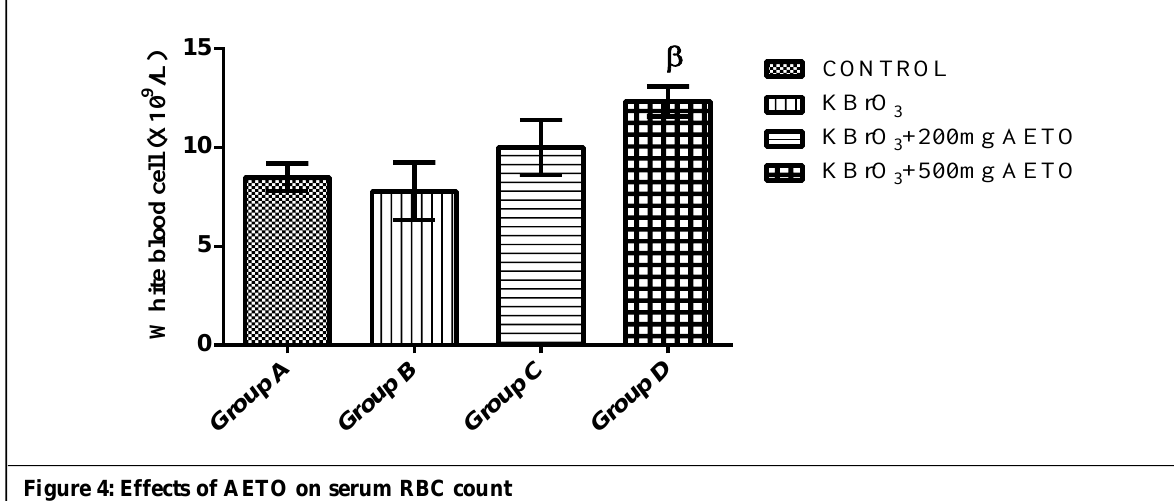
Figure 4: Effects of AETO on serum RBC count Note: Value of p < 0.05 was considered significant. The values with superscript  = significantly different from group A,  = significantly different from group B. WBC – White Blood